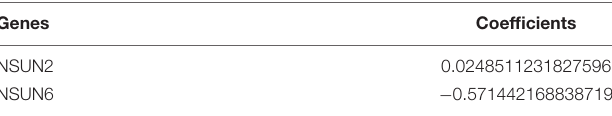
TABLE 4 | Genes selected to build risk signature and the corresponding coefficients. Genes